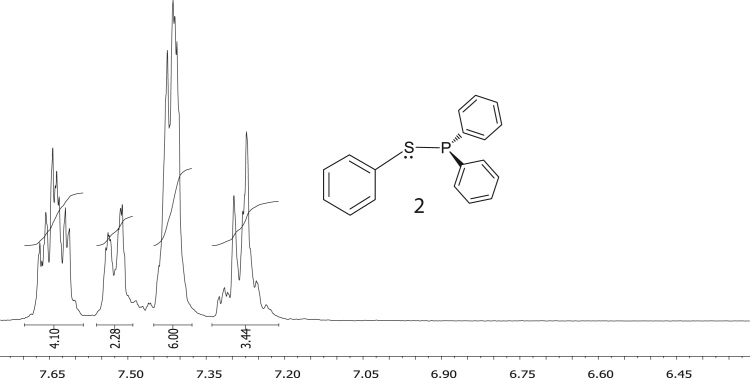
1H NMR of diphenylphosphinothious acid, C6H5SPPh2, 2.